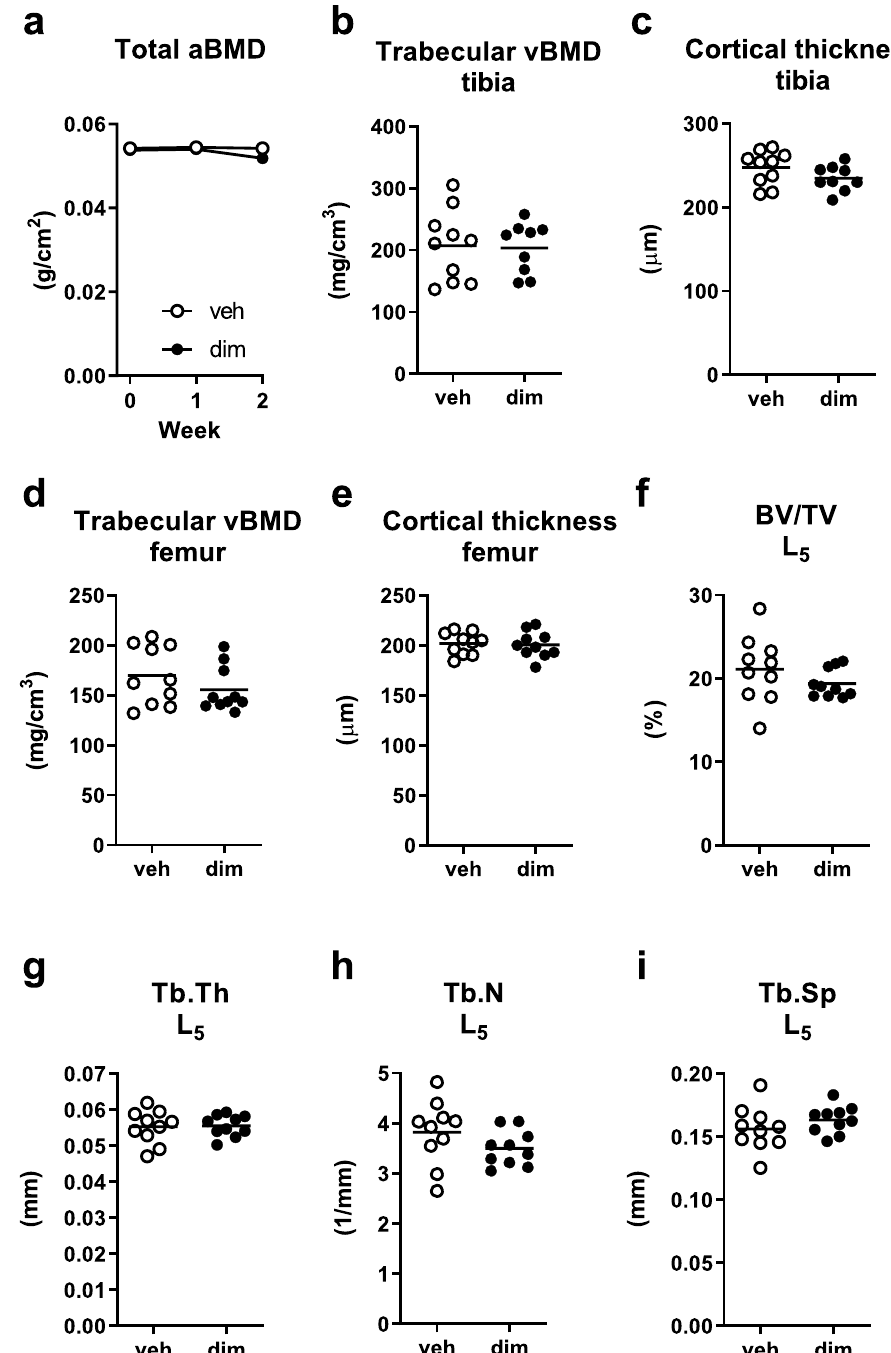
Figure 2. Short-term adipose tissue loss did not affect structural bone parameters. ( a ) Total areal bone mineral density (aBMD) measured by DXA at 0, 1, and 2 weeks after dimerizer injection. ( b ) Trabecular volumetric BMD (vBMD) of tibia, ( c ) cortical thickness of tibia, (d) trabecular vBMD of femur, and ( e ) cortical thickness of femur measured by pQCT 2 weeks after dimerizer injection. ( f ) Trabecular bone volume fraction (BV/TV), ( g ) trabecular thickness (Tb.Th), ( h ) trabecular number (Tb.N), ( i ) trabecular separation (Tb.Sp) of vertebra